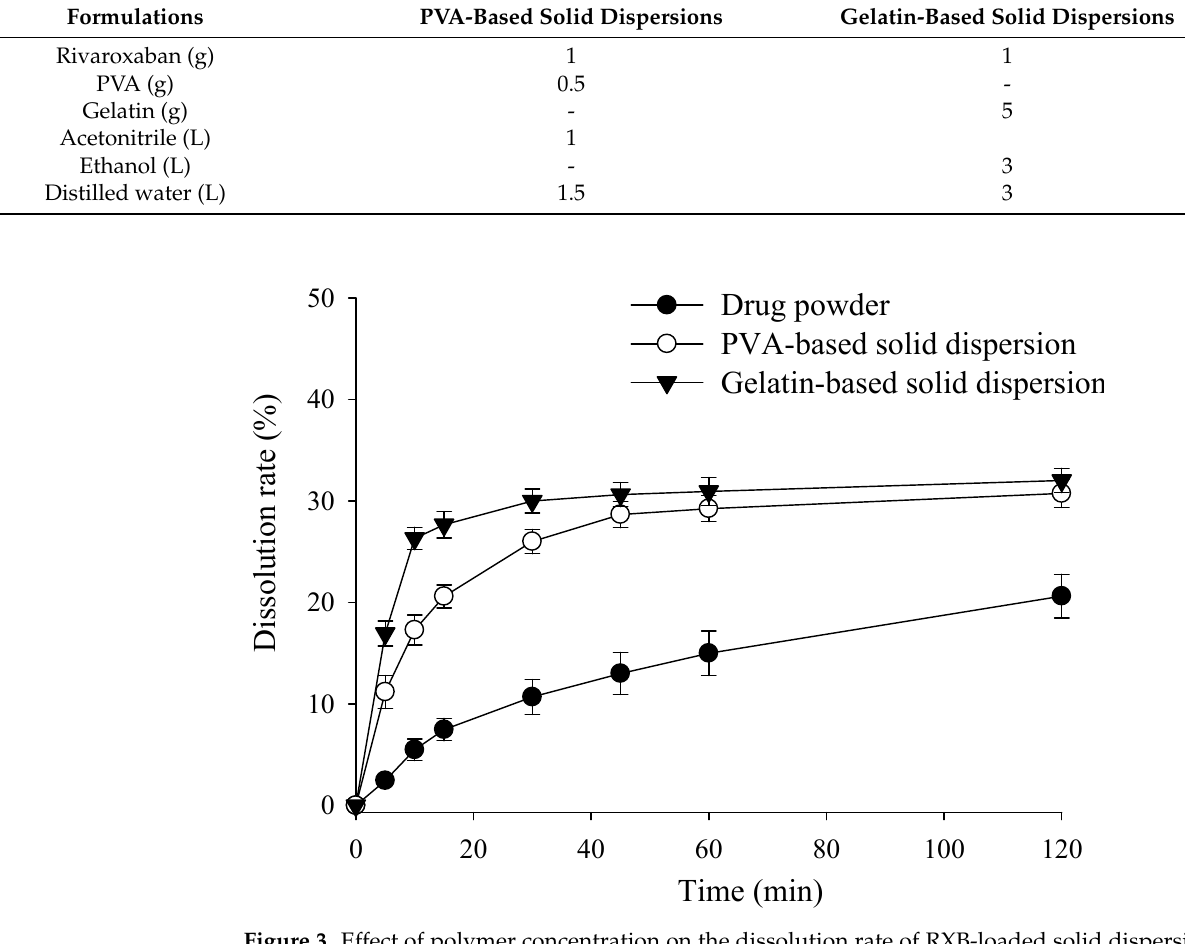
Figure 3. Effect of polymer concentration on the dissolution rate of RXB-loaded solid dispersions. Each value shows the mean ± S.D. ( n = 3).